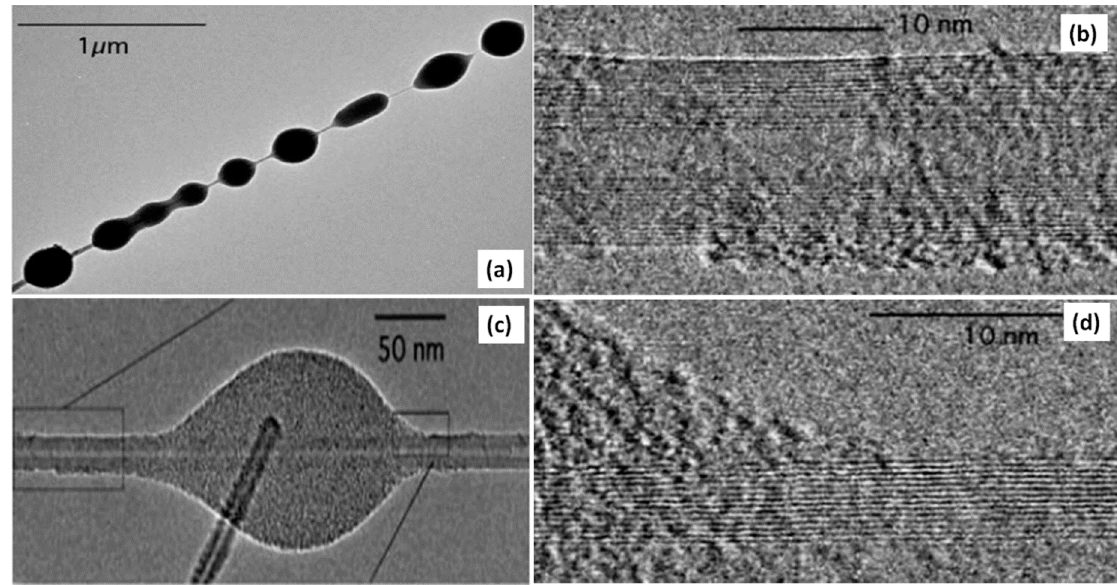
Figure 10. ( a ) TEM image of a MWNT with many beads; ( c ) TEM image of a small, elongated bead on MWCNT of 15 layers; ( b , d ) High ‐ resolution TEM images of the beads. Reproduced with permission from [100]. Copyright AAAS, 2005.